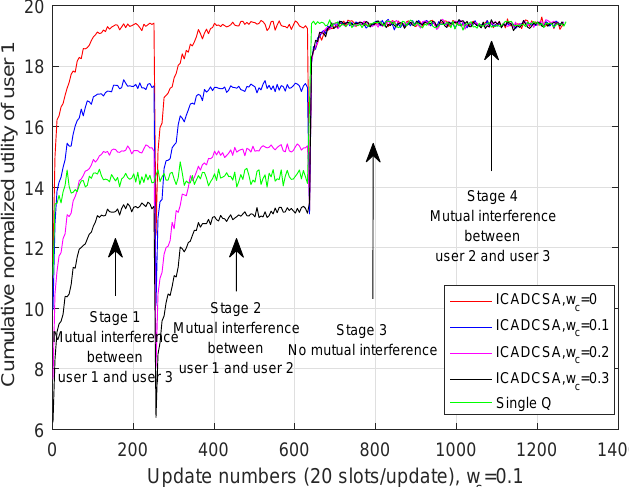
Figure 12. The cumulative normalized utility of User 1 with different cooperation costs.